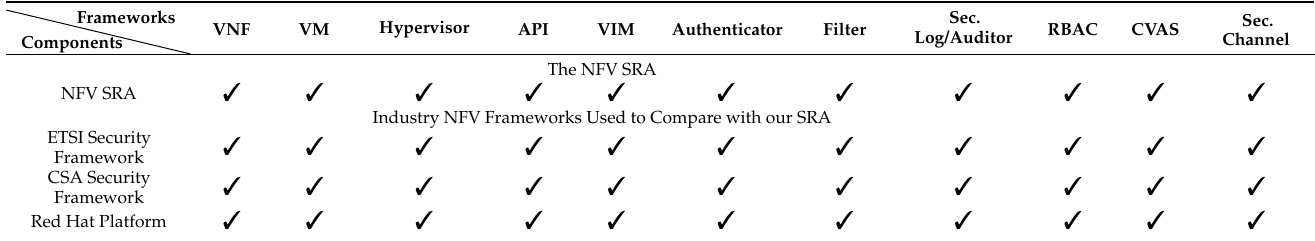
Table 3. Validation of the Security Reference Architecture of NFV .